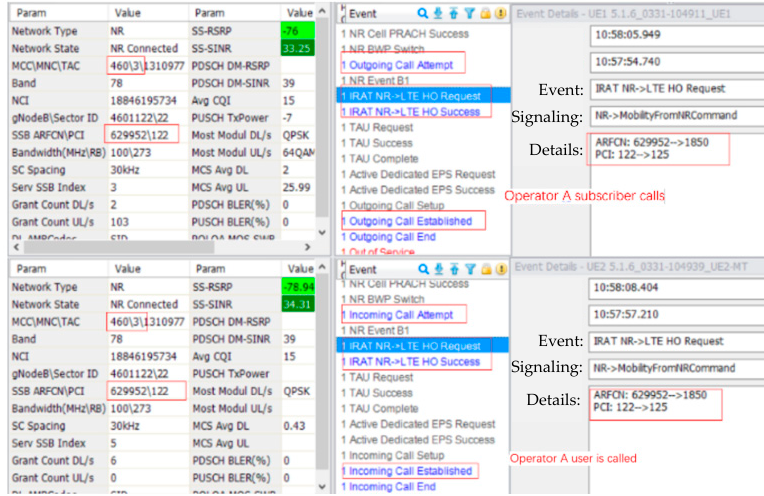
Figure 14. EPS fallback test process based on the handover.